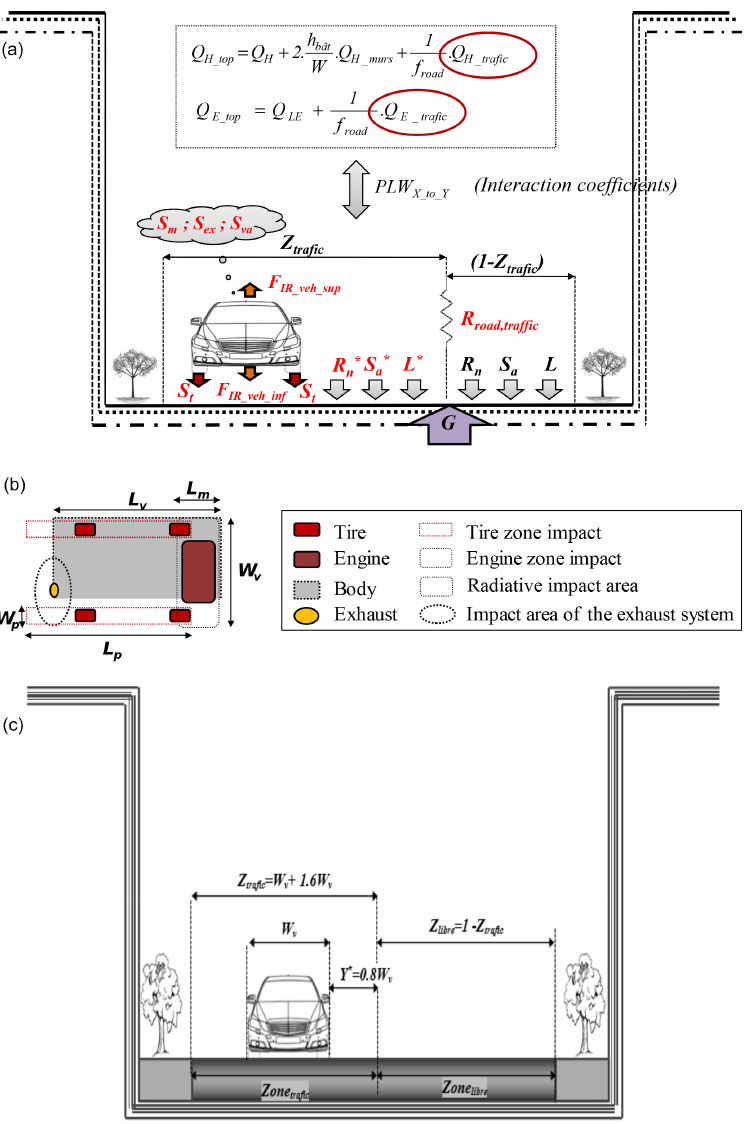
Figure 4. TEB configuration with traffic integration (a) , its impact zones of the different processes (b) and the limits of the traffic impact zone (c)